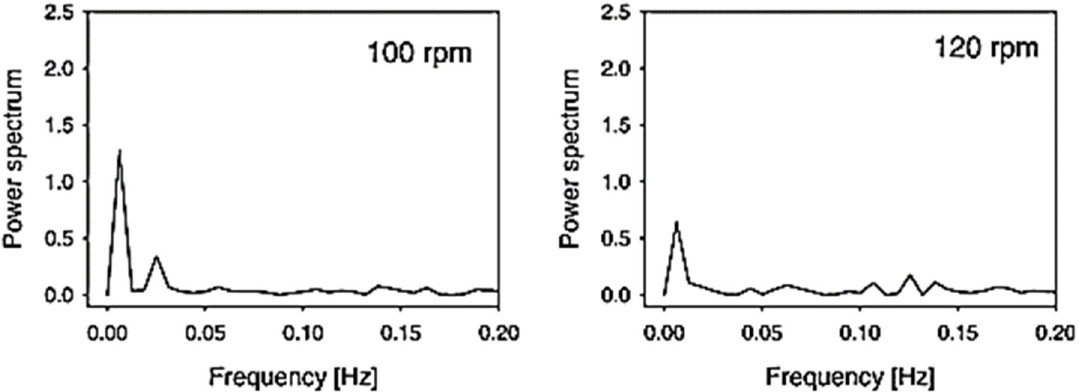
Figure 17. Power spectrum of the bottom zone of the bed for different agitation speeds [149].